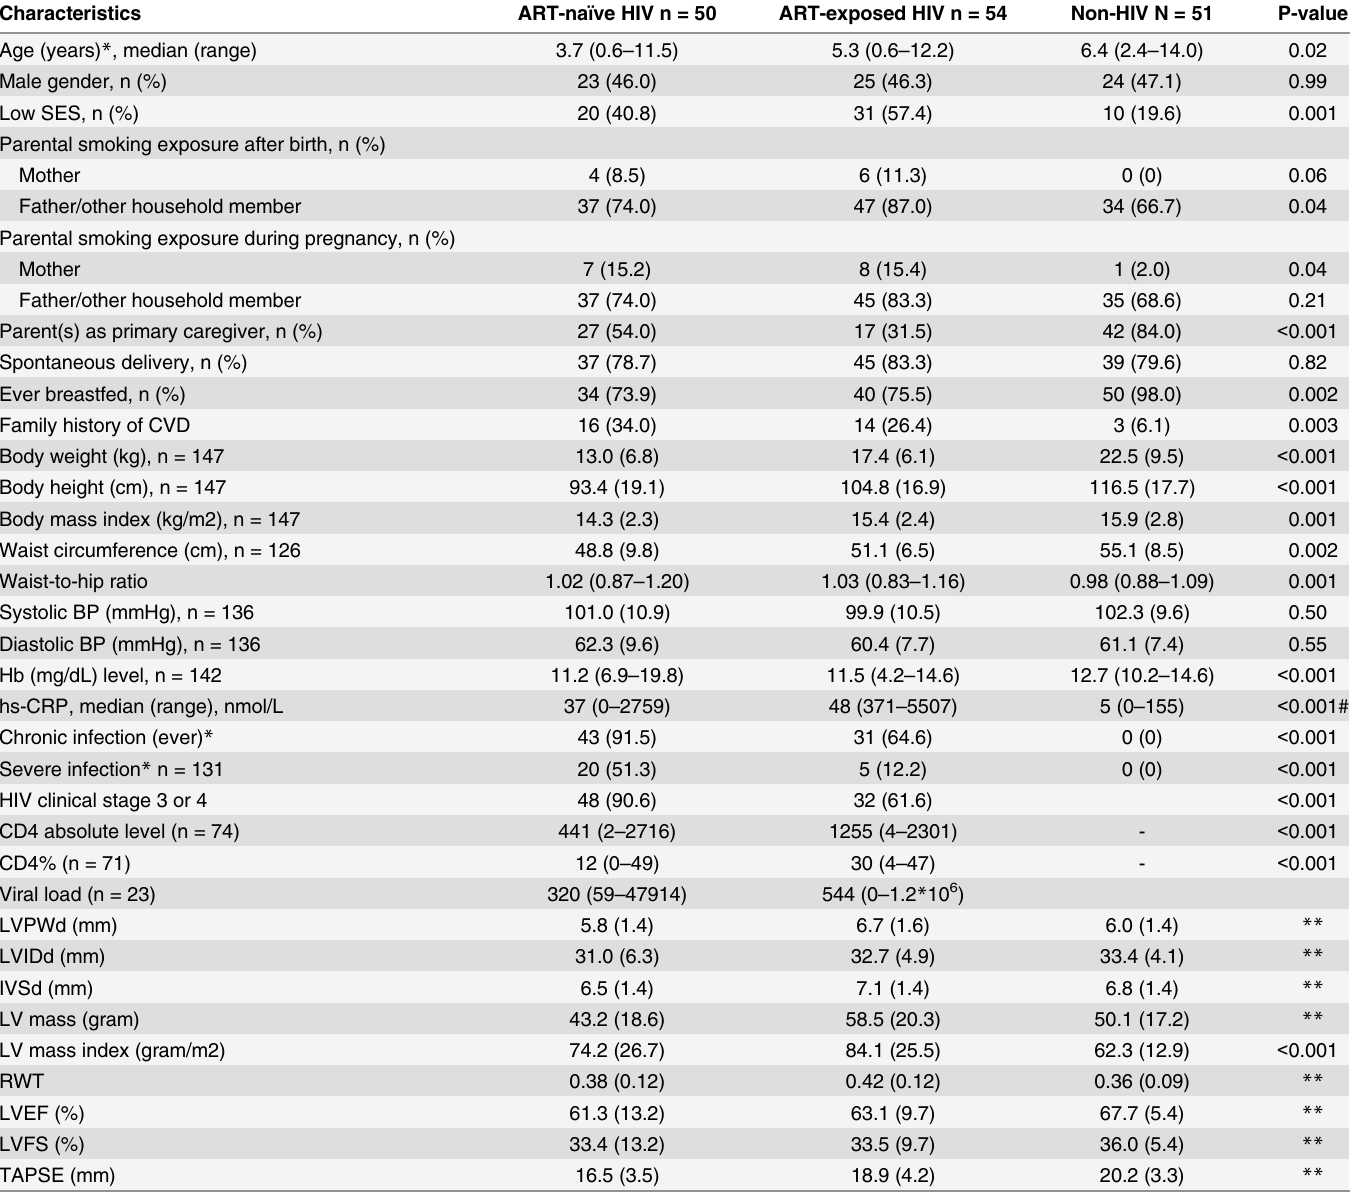
Table 1. Baseline characteristics of study